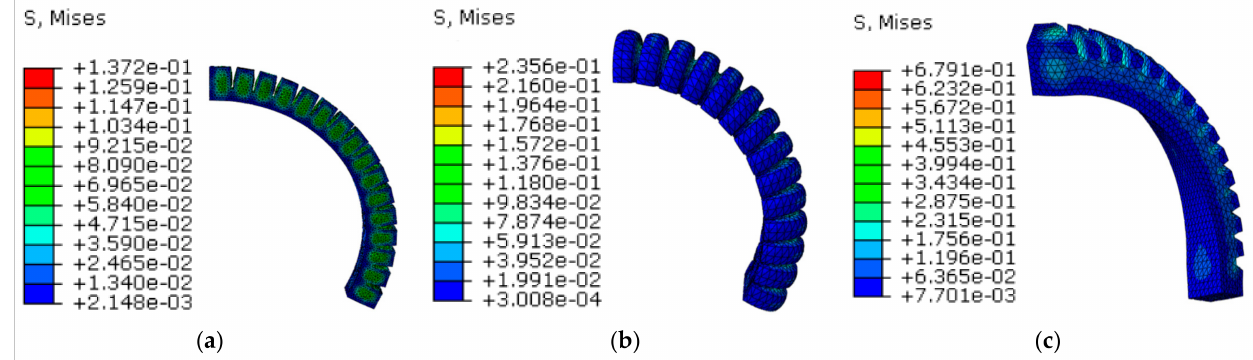
Figure 2. Simulation results of the soft manipulator at 25 kPa: ( a ) step-function type; ( b ) sine-function type; ( c ) Ramp- function type.